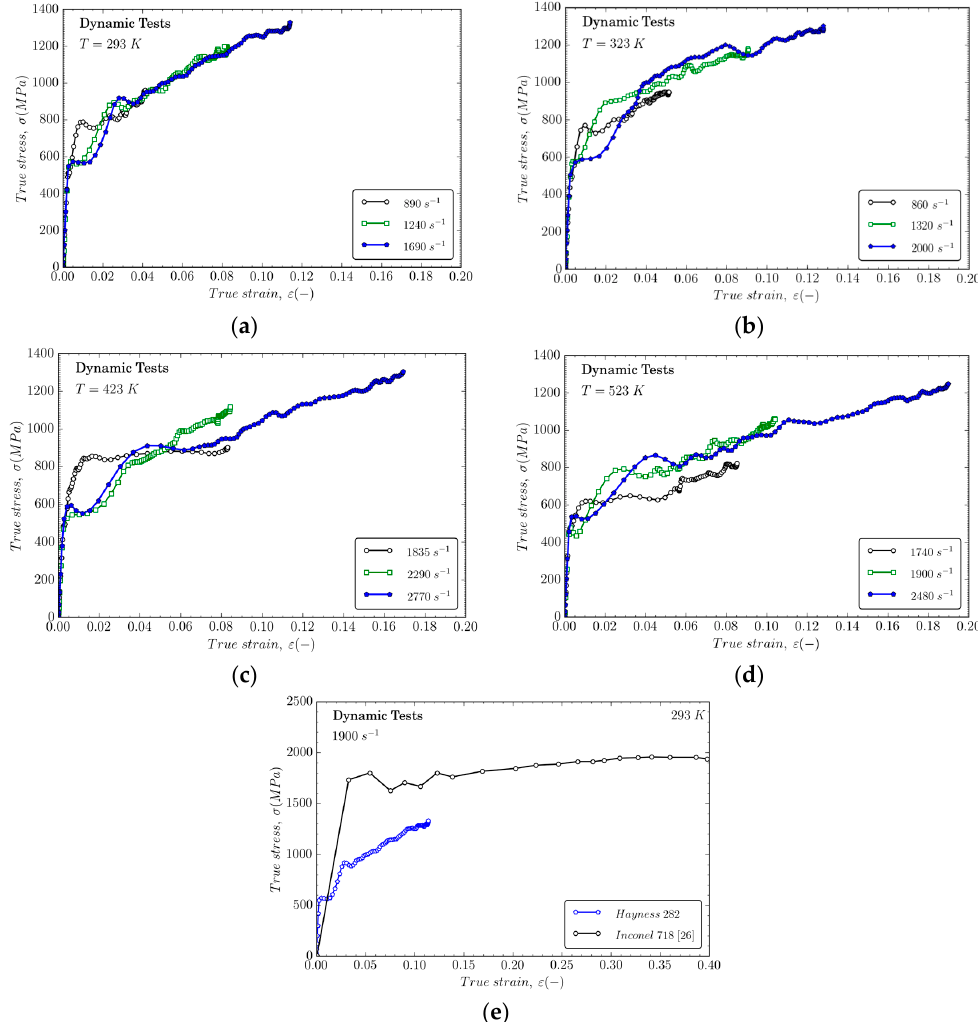
Figure 3. Flow stress evolution versus true strain for different strain rates at different temperatures: ( a ) 293 K; ( b ) 323 K; ( c ) 423 K; and ( d ) 523 K; ( e ) Comparison of mechanical behavior for Haynes 282 and Inconel 718 at 1900 s − 1 and at room temperature [26].